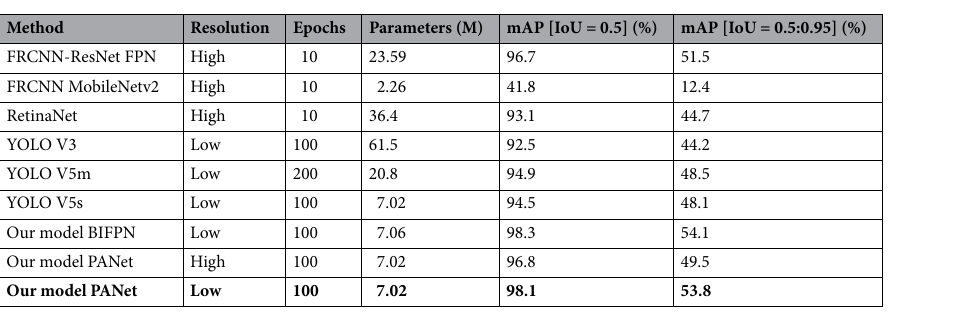
Table 1. Mean average precision (mAP) for PCB defect classification across models. The values in bold represent the results of the proposed model.